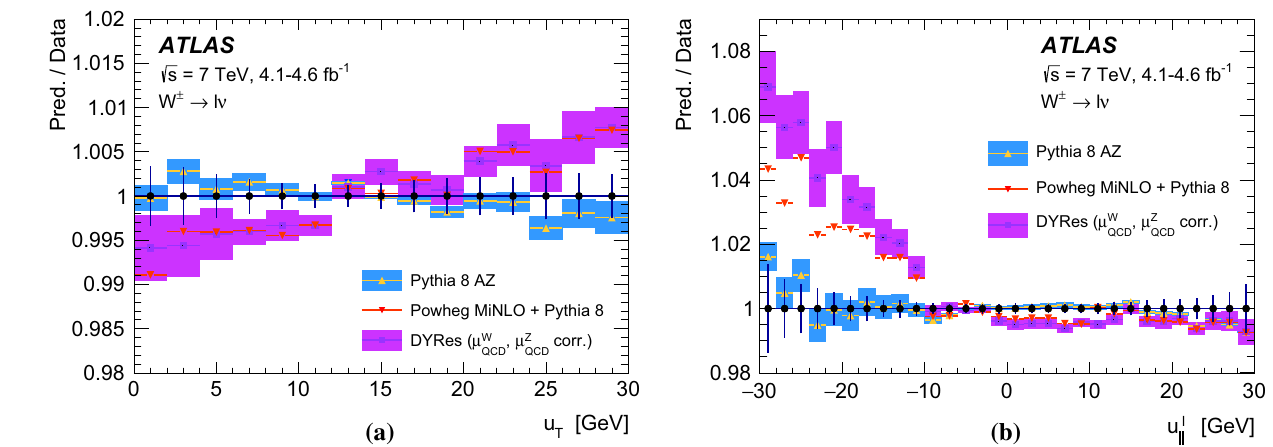
smallest total uncertainty in m W is found for the fit ranges < 45 GeV and 66 < m 32 < p (cid:7) T